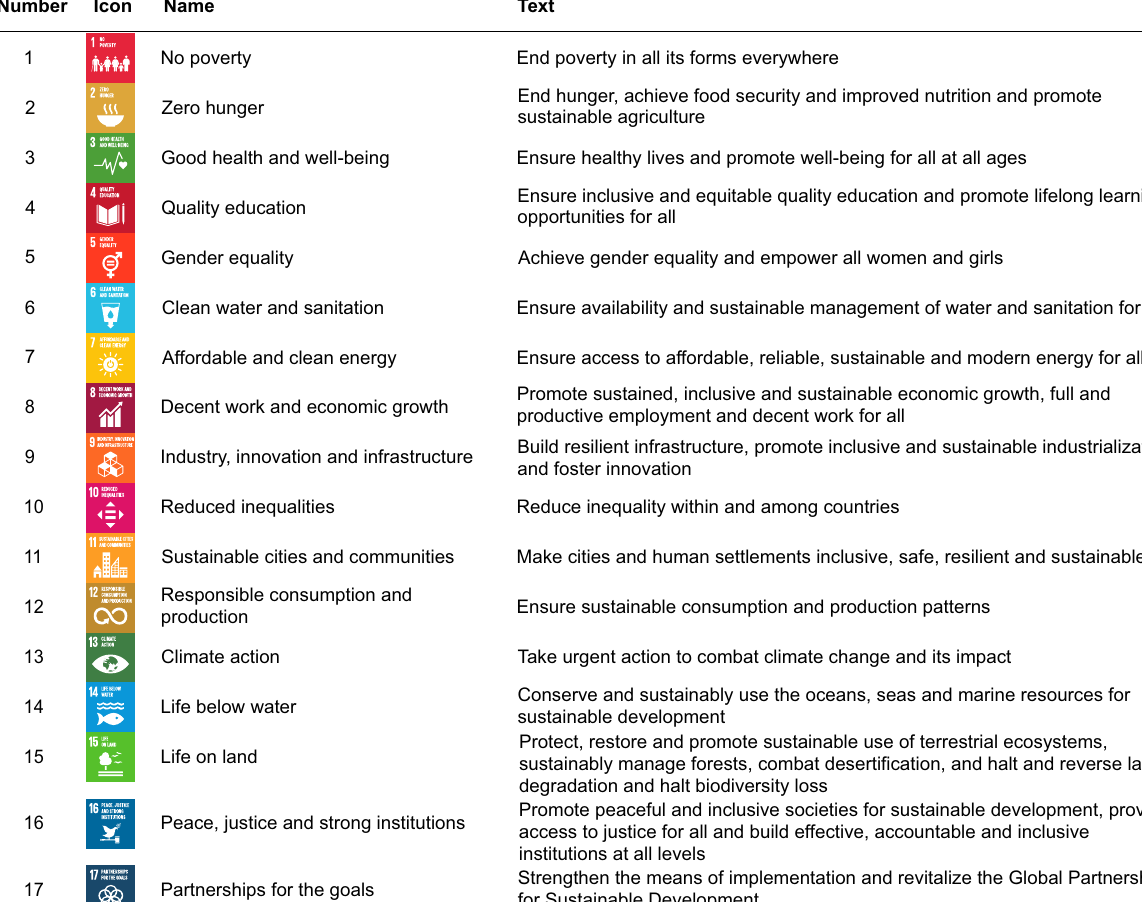
Fig. 1 The 17 Sustainable Development Goals as presented by the United Nations 1 (https://www.un.org/sustainabledevelopment/), with their numbers, icons, titles and full text. Descriptions of the targets are given in Supplementary Figs. 3 – 11. The content of this publication has not been approved by the United Nations and does not re fl ect the views of the United Nations or its of fi cials or Member